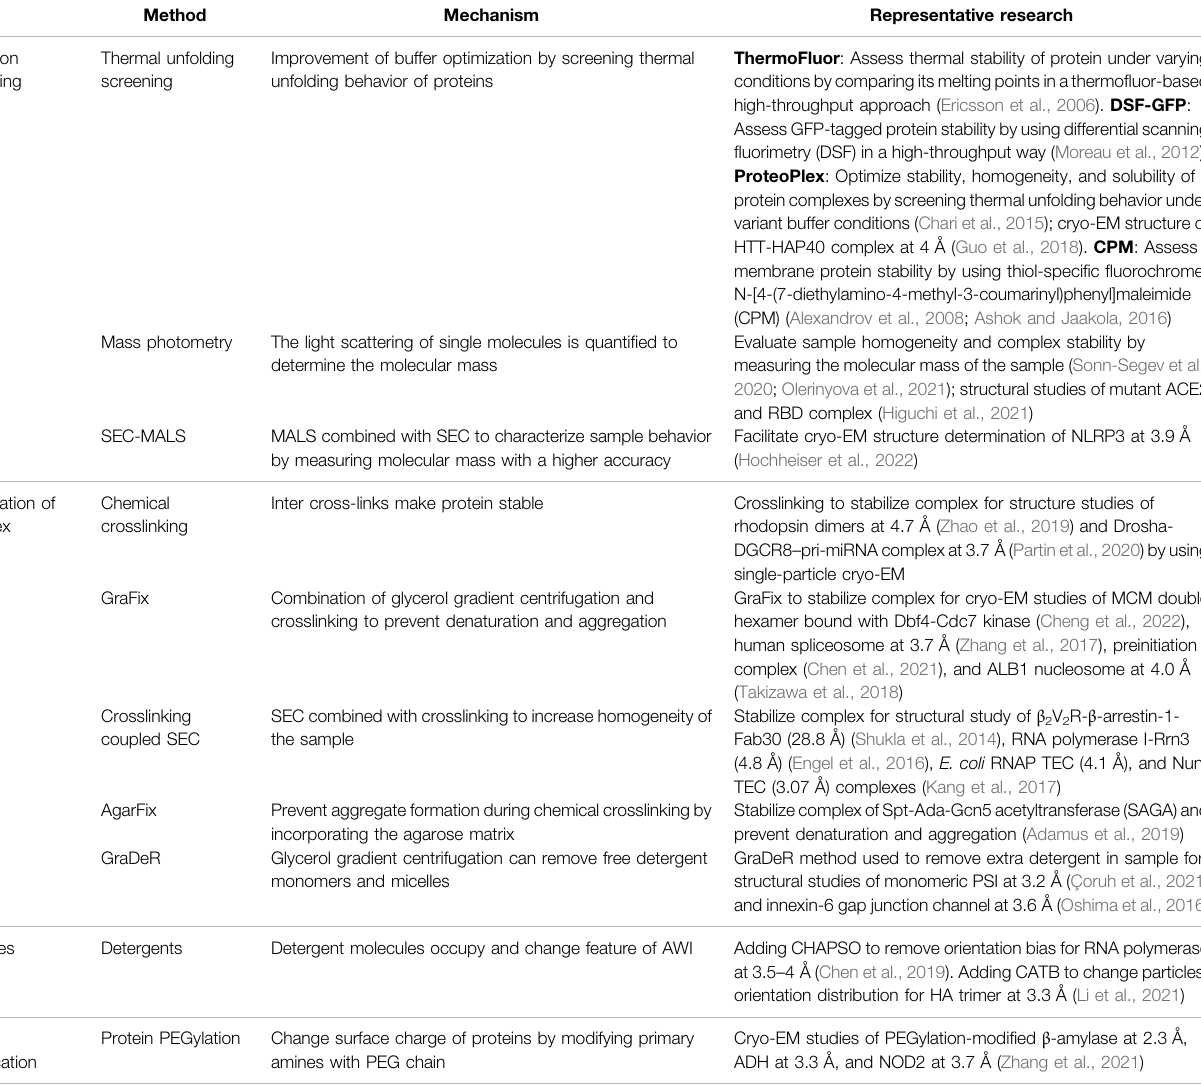
TABLE 1 | Summary of biochemical methods to improve the quality of